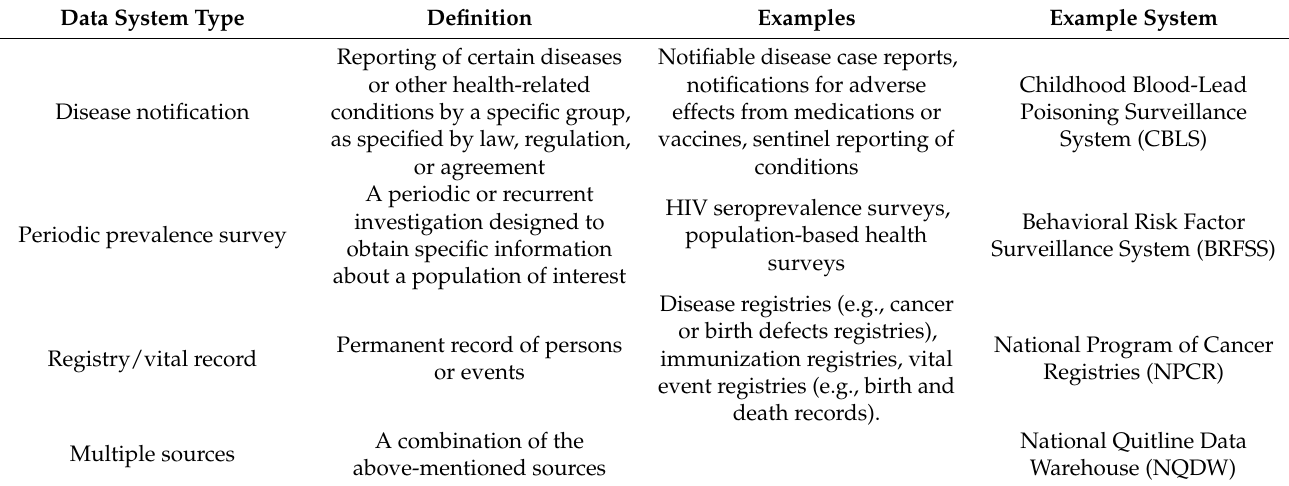
Table 1. Types of data systems, definitions, and examples 1